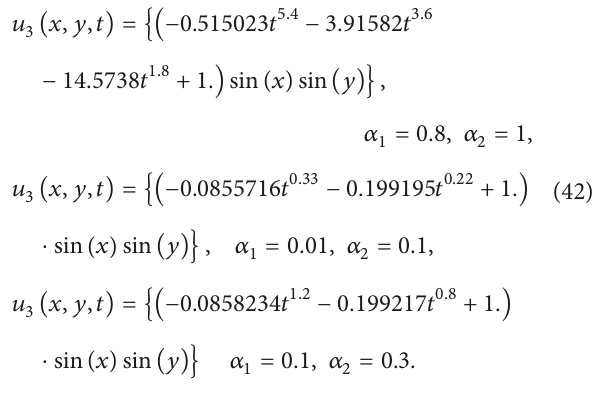
The approximate solutions for different values of 𝛼 1 and 𝛼 2 , 𝛽 = 2 ,